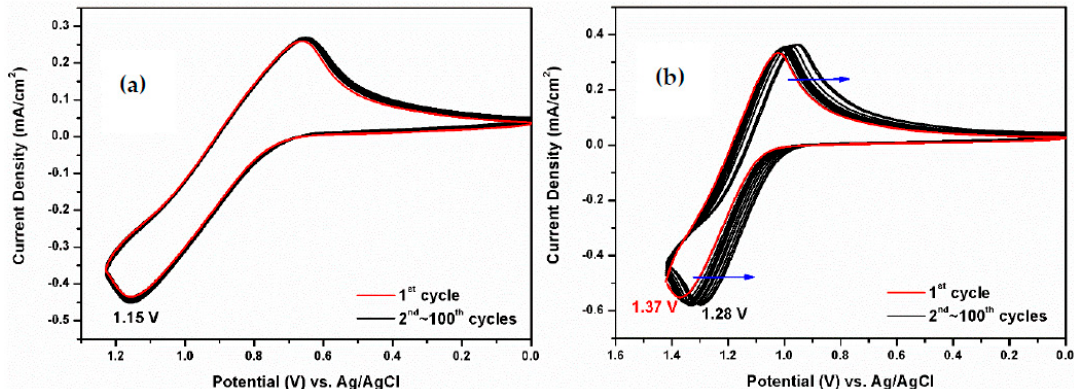
Figure 11. Cyclic voltammetry (CV) diagrams of 2 mM of model compounds ( a ) M1 and ( b ) M2 in 0.1 M Bu 4 NClO 4 /CH 2 Cl 2 solution at a scan rate of 50 mV·s − 1 .